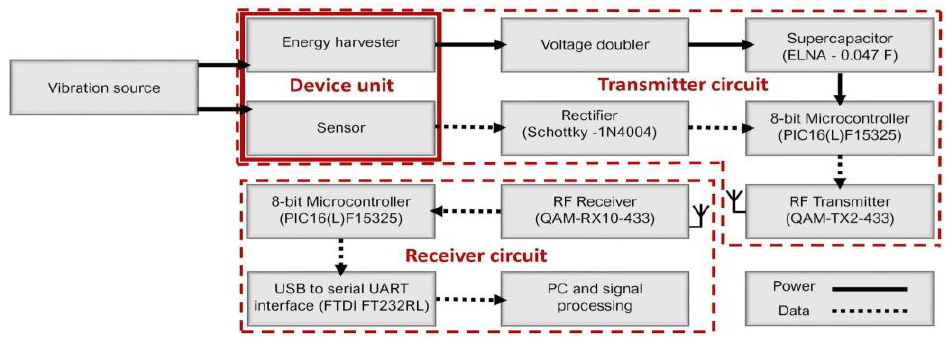
Figure 2. Block diagram showing the layout of the proposed wireless self-powered, self-contained, eco-friendly vibration sensor system.